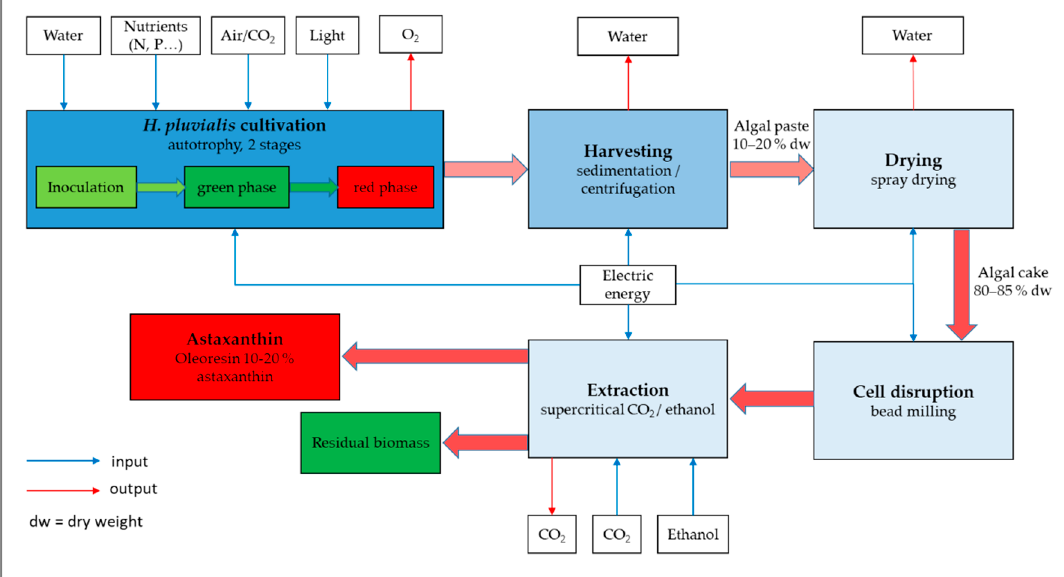
Figure 6. Flow chart of a possible astaxanthin production process ([1,204].